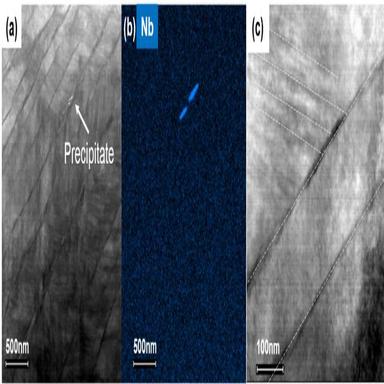
(a) Panoramic bright field TEM images showing the microstructure of alloy 709 subjected to a tensile test at 500 C. (b) Bright field and corresponding dark field TEM images showing the dislocation cells/walls formed during tensile deformation at 500 C. (c) Elemental Maps showing the (Cr, Mn)-rich carbides and Nb-rich MX precipitates (d) higher magnification micrograph showing deformed Nb-rich MX precipitates.